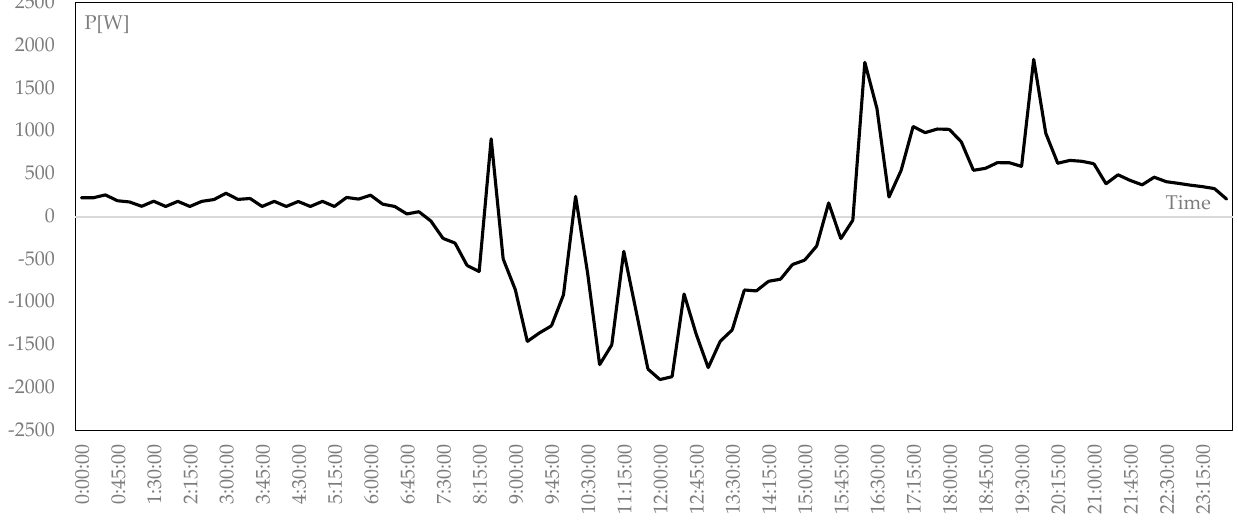
Figure 15. ESS state of charge.